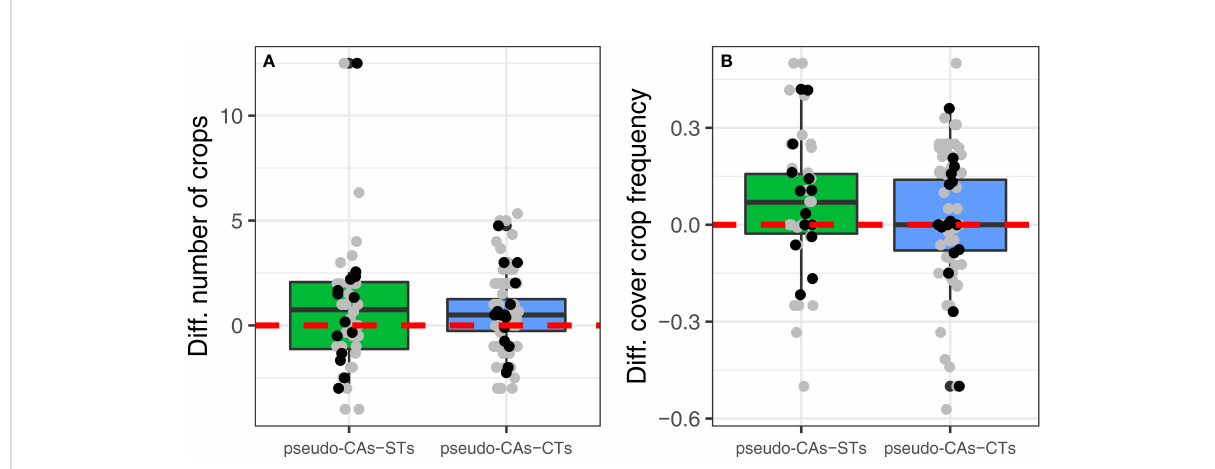
FIGURE 5 Distributions of the differences in response variables between pseudo-conservation agriculture systems (pseudo-CAs) and their reference conventional tillage (CTs, blue boxplots) and super fi cial tillage (STs, green boxplots) based systems for: the number of crops (A) and the frequency of summer fallow cover crops (B) . Grey dots represent individual differences between systems. Black dots represent average differences per cluster. Red stars indicate signi fi cant differences between pseudo-CAs and its reference system (either CTs or STs) at p<0.05, cluster accounting for the production situation included as a random effect in the model (see details in Table 2).